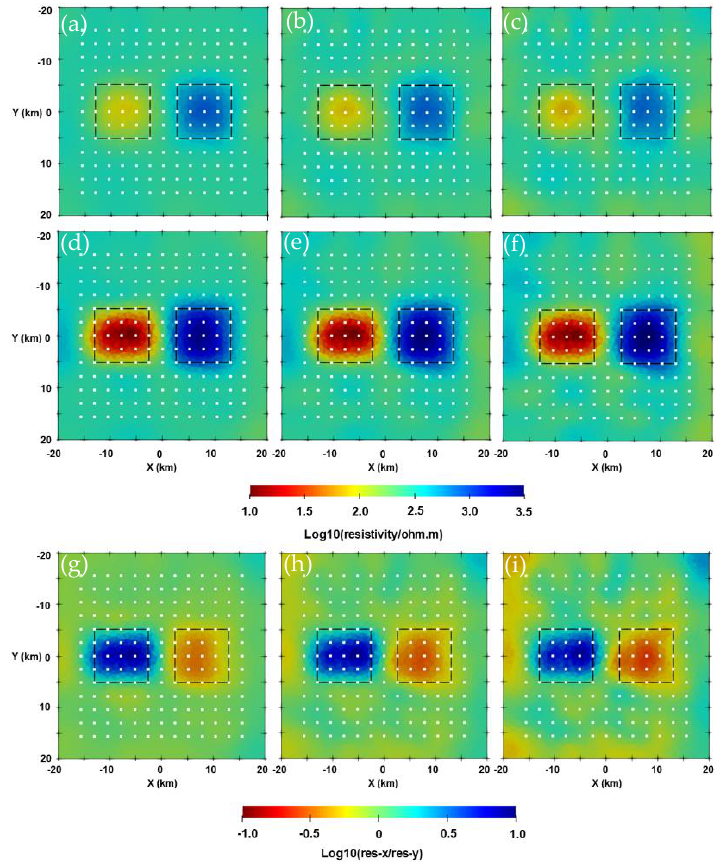
Figure A8. Anisotropic inversion results at z = 6 km. Panels ( a ) – ( c ) show the inverted resistivity in the principal X direction for 2%, 5%, 8% noise level. Panels ( d ) – ( f ) show the inverted resistivity in the principal Y direction for 2%, 5%, 8% noise level. Panels ( g ) – ( i ) show the inverted anisotropic coefficient for 2%, 5%, 8% noise level.